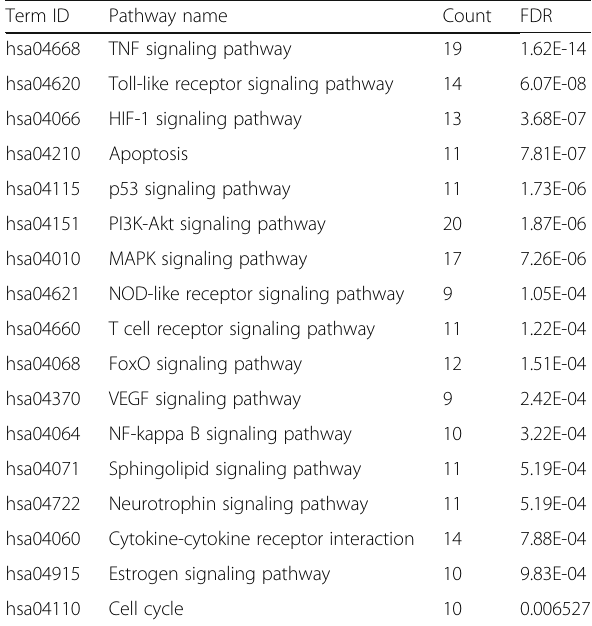
Table 2 Information on 17 pathways